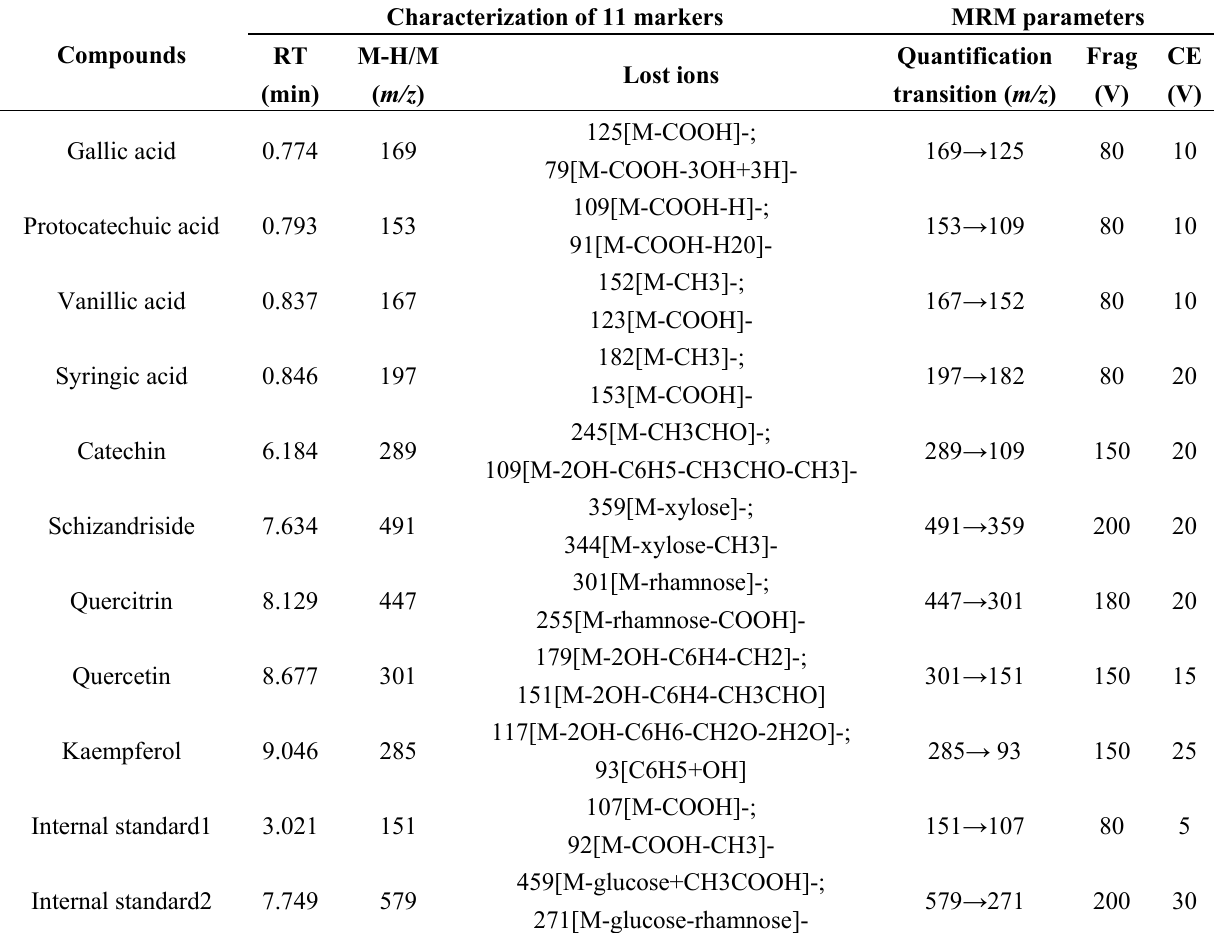
Table 1. Characterization of 11 markers on the LC-MS and the optimized MRM parameters for quantification.